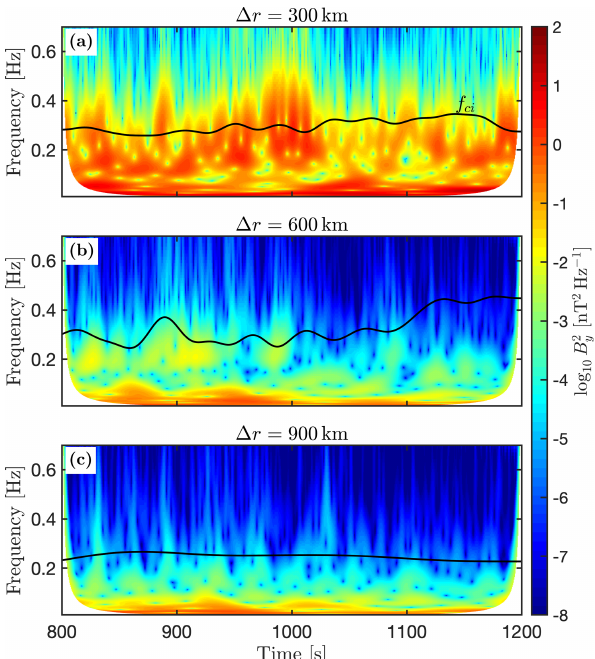
Figure 3. Wavelet analysis of the magnetic field for the virtual space craft locations given in Fig. 1. The coloured background represents the power spectrum density of the y component of the magnetic field. Panel (a) displays the results for the run at a resolution of (cid:49)r = 300km, panel (b) the run at a resolution of (cid:49)r = 600km and panel (c) the run at a resolution of (cid:49)r = 900km. The black curve in each plot indicates the proton cyclotron frequency.